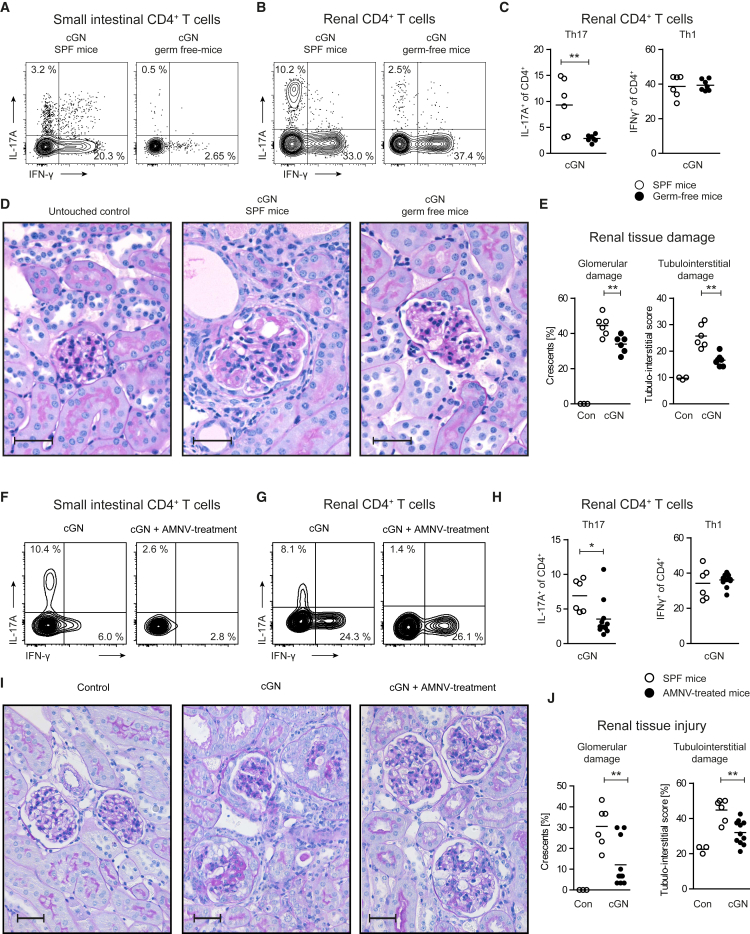
Renal Th17 Response in cGN Is Dependent on Intestinal Microbiota(A) Flow cytometry of CD4+ T cells from the small intestinal lamina propria of GFM and SPF mice after induction of cGN.(B and C) Flow cytometry of renal CD4+ T cells for IL-17A and IFN-γ expression.(D) PAS staining of renal cortex from cGN and control mice. Scale bar, 20 μm.(E) Glomerular crescent formation and tubulointerstitial damage (score) in the respective groups. See also Figure S5.(F–J) Mice were treated with a combination of 4 antibiotics (AMNV) for 4 weeks prior to induction of cGN. (F) Small intestinal CD4+ T cells and (G) renal CD4+ T cells were analyzed for IL-17A and IFN-γ. (H) Quantification of cytokine expression in renal CD4+ T cells. (I) PAS staining of renal cortex of mice with AMNV treatment and control mice. (J) Quantification of renal damage.See also Figure S6. Data are representative of three independent experiments. Symbols represent individual data points, with the mean as a horizontal line. Scale bar, 20 μm. ∗∗p < 0.01.